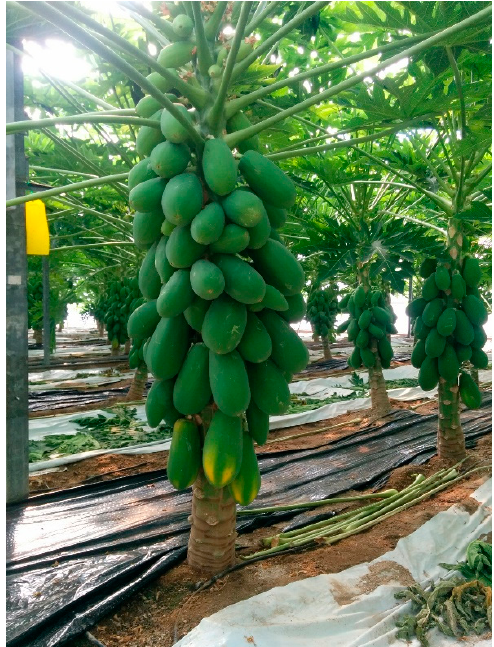
Figure 3. Papaya plant under greenhouse with fruits close to harvest.